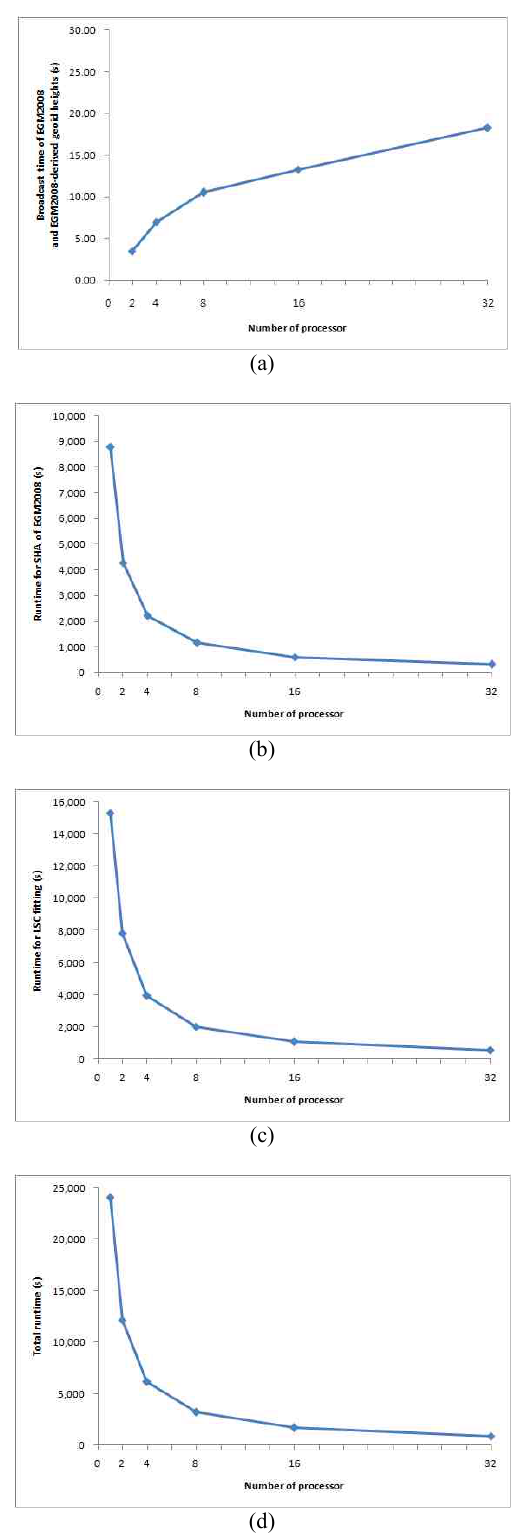
Figure 3. Running time of hybrid MPI and OpenMP application for computing of SHA and LSC. (a) broadcast time of EGM2008 and the EGM2008-derived geoid heights, (b) runtime for SHA of EGM2008, (c) runtime to find optimum correlation length using LSC fitting, and (d) total computation